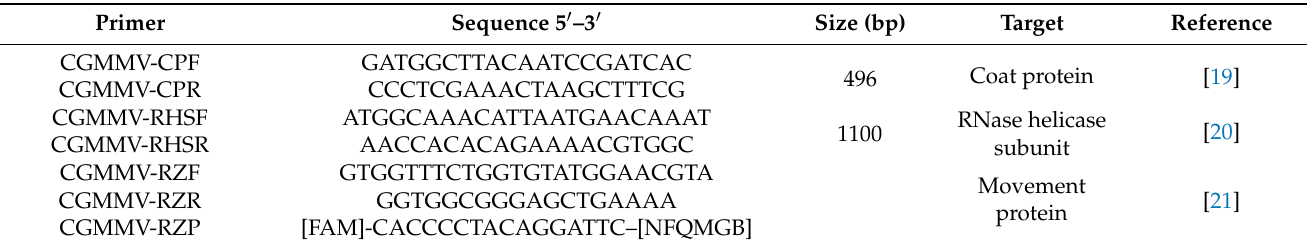
Table 2. Primers used for RT-PCR and RT-qPCR detection of cucumber green mottle mosaic virus